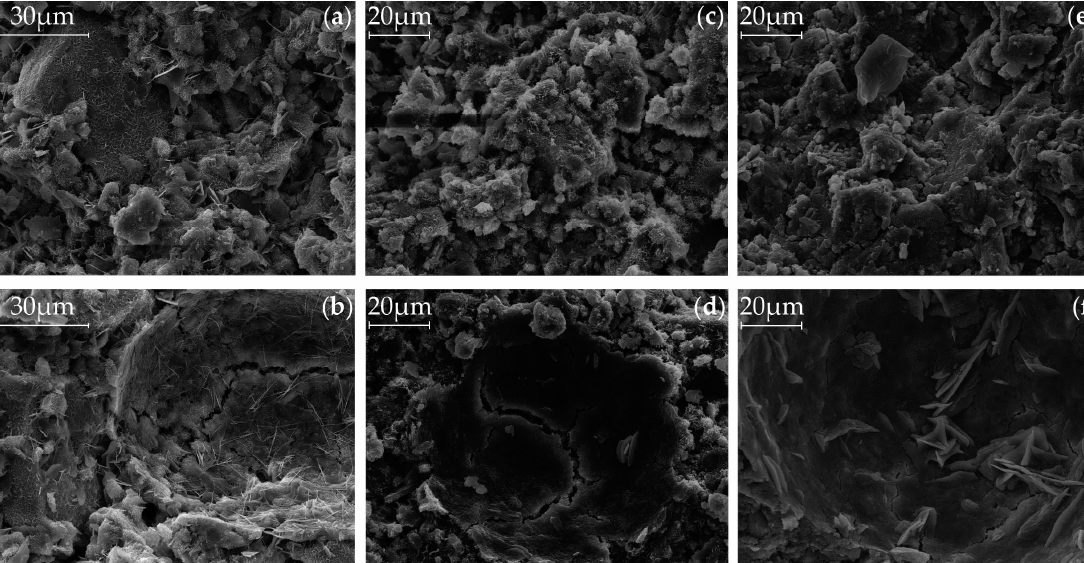
Figure 8. SEM pictures after a hydration period of seven days, of the reference (( a ) of surface and ( b ) of pore) and the reactivated mixtures with Ac2 after seven days of retardation (( c ) of surface and ( d ) of pore with 0.25%R, ( e ) of surface and ( f ) of pore with 1.00%R).